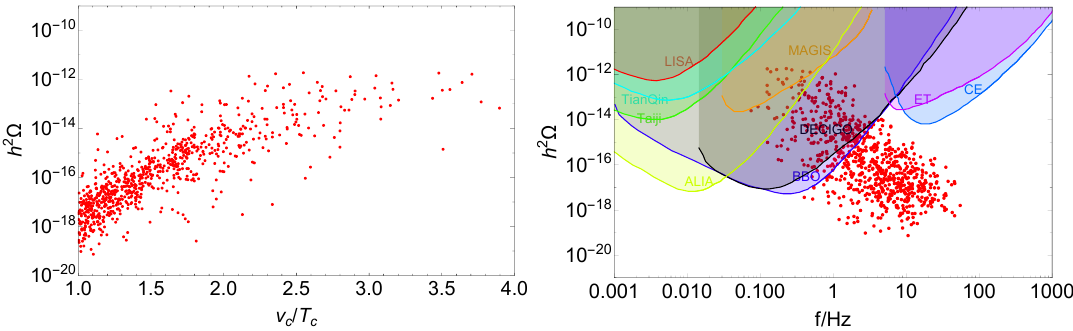
Figure 5 . GW peaks for the data points in figure 4, as function of v c /T c (left) and frequency f (right). Also shown in the right panel are the prospects of LISA [35, 36], TianQin [33], Taiji [34], ALIA [37], MAGIS [38], BBO [40], DECIGO [39], ET [42], and CE